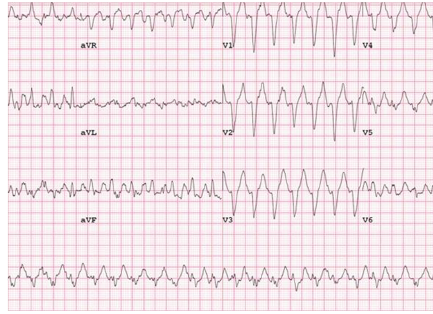
Figure 2: Electrocardiogram at peak exertion demonstrating left bundle branch block morphology.